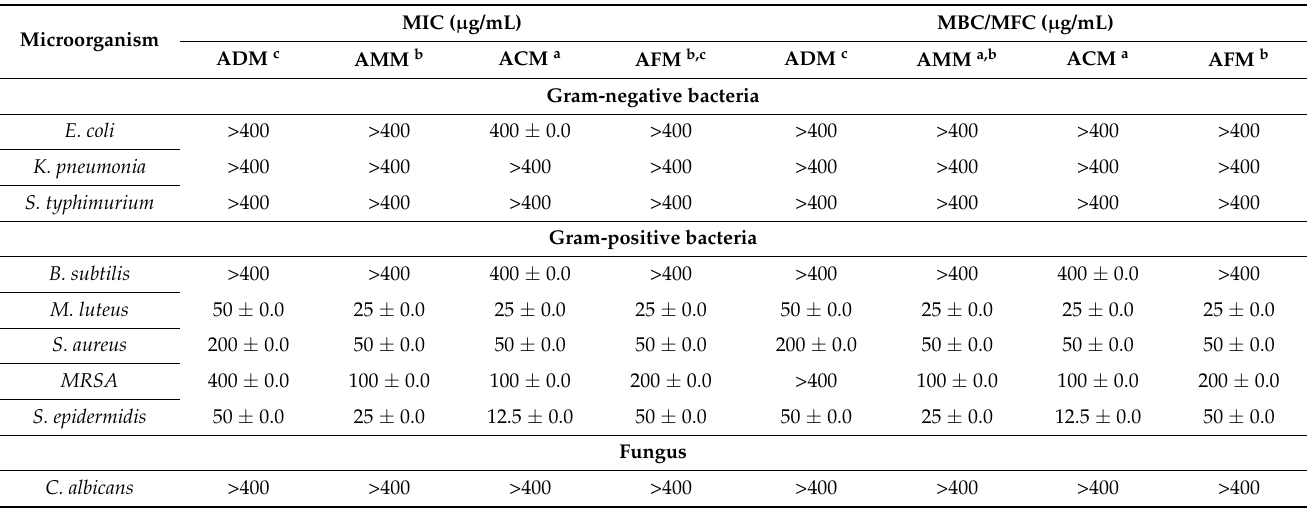
Table 5. Minimum inhibitory concentrations (MICs) and minimum bactericidal concentrations (MBCs) of melittin from four honey bee species against pathogenic bacteria.